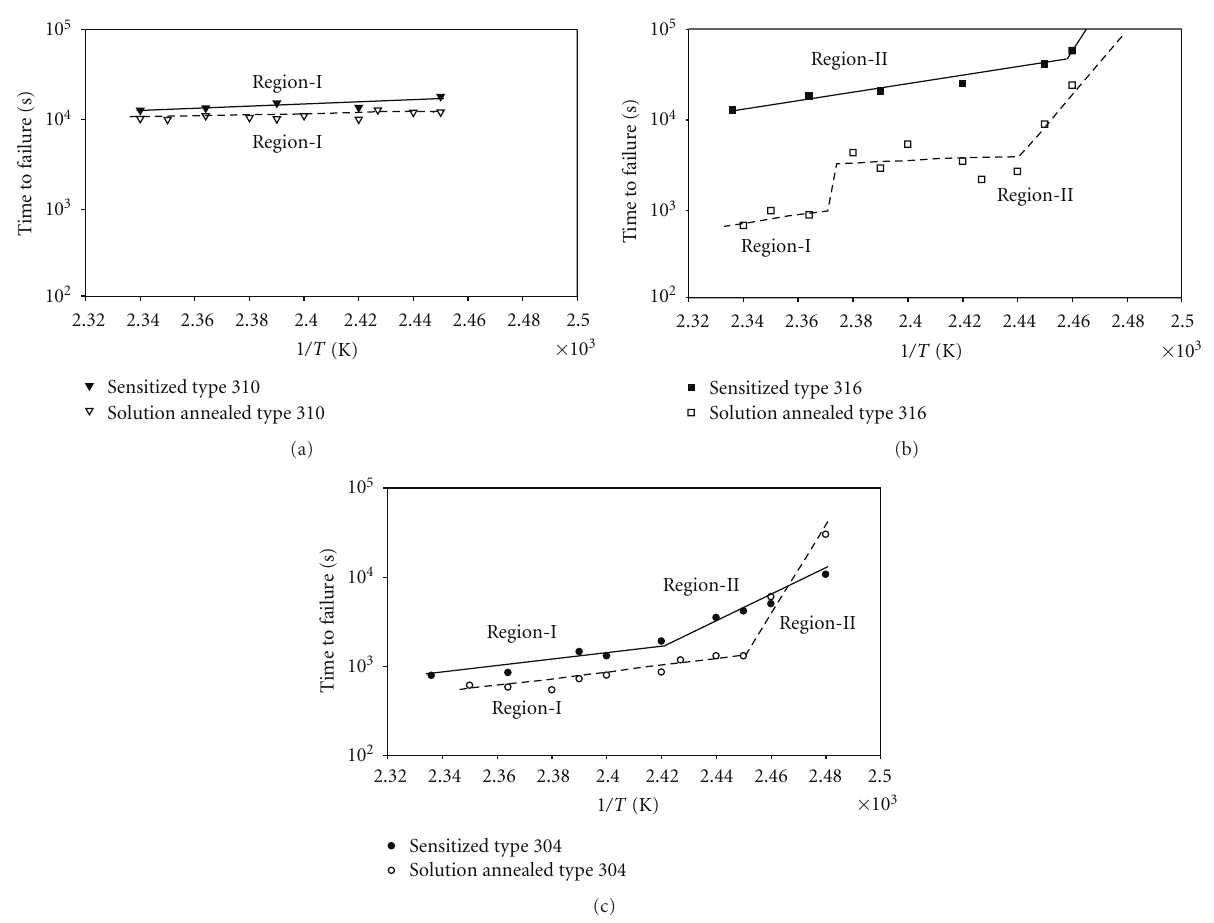
Figure 6: The relationship between reciprocal of test temperature (1 /T ) and logarithm of time to failure ( t f ) for sensitized type 310, 304 and 316 steels in boiling saturated MgCl 2